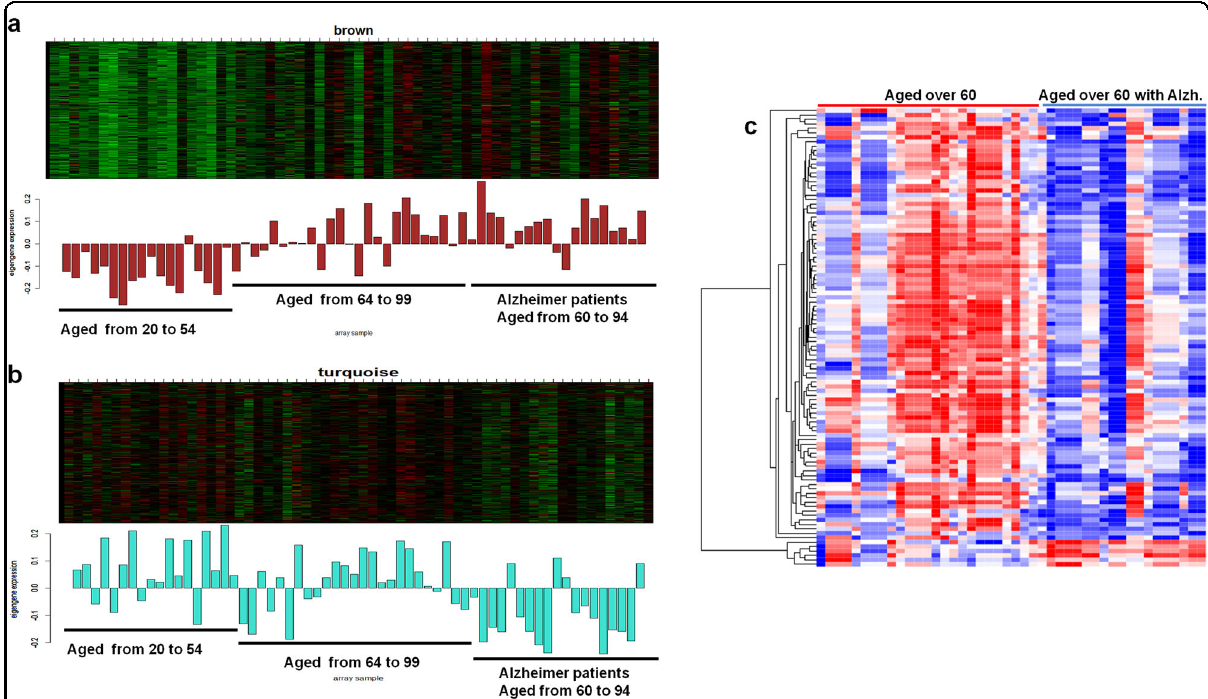
Fig. 5 Gene expressions for Alzheimer ’ s disease. Co-expressed genes were enriched in immune process ( a ) and synaptic transmission ( b ). Bar plots correspond to eigengenes. c Differentially expressed genes between AD patients and the age-matched normal were enriched in synaptic transmission. Most of them were downregulated in AD compared with the